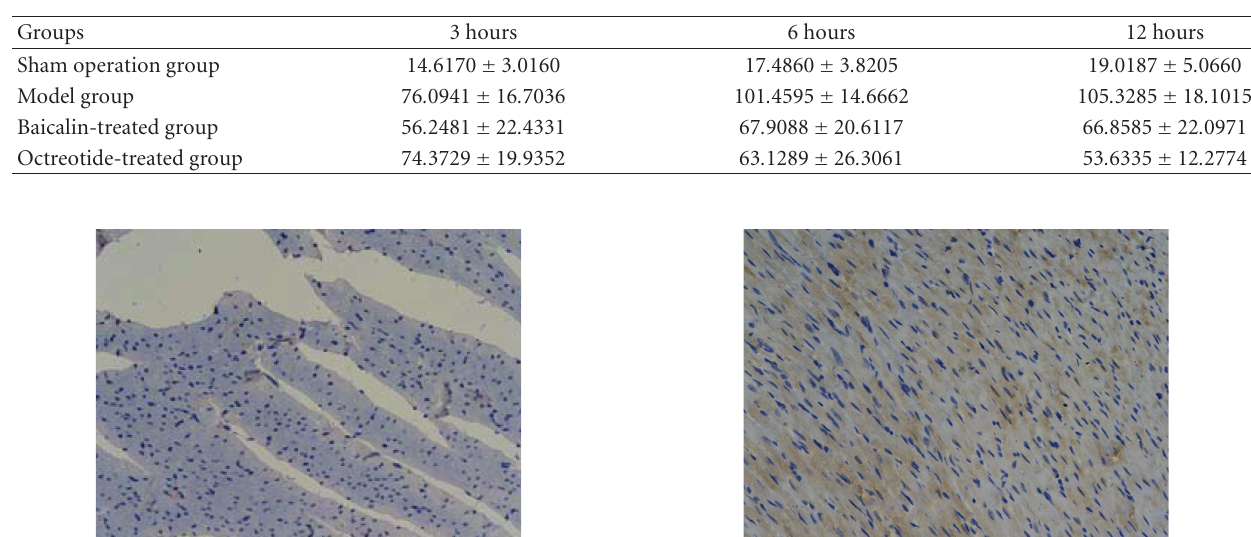
Table 2: Comparison of serum PLA 2 content in all groups ( X ± S ).